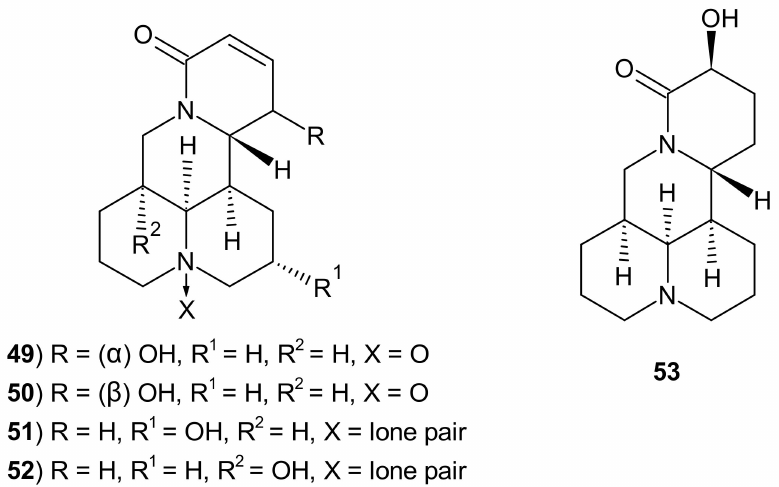
Figure 15. Structures of 12-hydroxyoxysophocarpine 49 – 50 , 9 α -hydroxysophocarpine 51 , sophoranol 52, and 14 β -hydroxymatrine 53